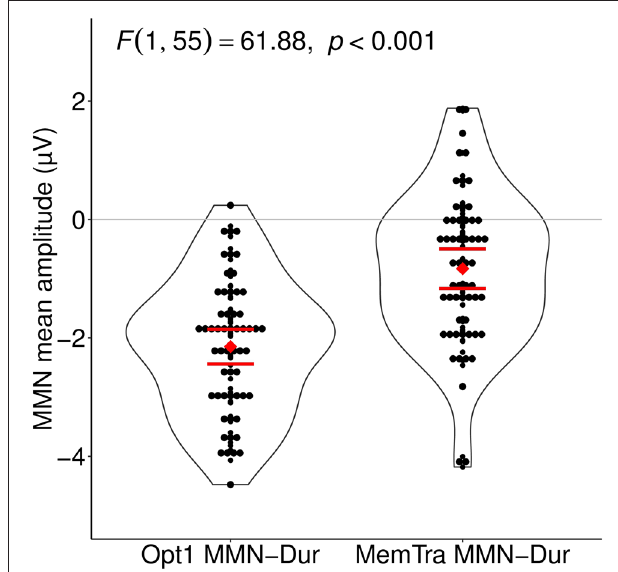
FIGURE 3 | Mean MMN after duration deviants in comparison between the Opt1 and the MemTra paradigm. Mean values build from the averaged signal of the fronto-central electrodes Fz, FCz, and Cz. The depicted F -value is accounted for Group main effect and Group × Paradigm interaction. 95% confidence intervals for the average MMN amplitude are shown as horizontal bars, red dot representing the mean value. Opt1, Optimum–1; MemTra, Memory Trace; MMN Opt–Dur, MMN after duration deviants in the Optimum–1 paradigm; MMN Memtra–Dur, MMN after duration deviants in the Memory Trace